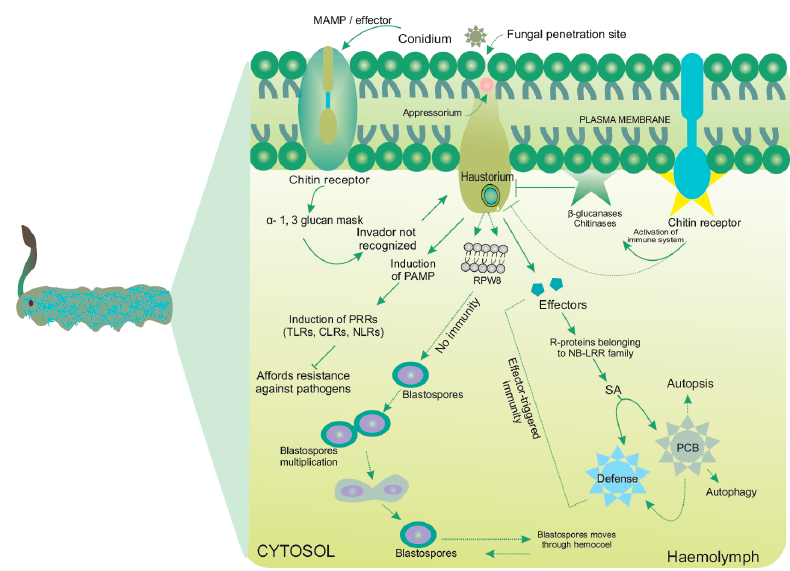
Figure 4. Detailed mechanism of fungal assault to insect larvae. Unlike in mammals, fungal cell-wall is endowed with several glycans, glycolipids and proteins. PAMPs trigger upregulation of immunity via several pathogen-recognition receptors (PRRs), such as Toll-like receptors (TLRs), C-type lectin receptors (CLRs) and NOD-like receptors (NLRs). CLRs such as N-linked mannans, galactomannans, β -1,3 glucans, α -mannals and α -mannosyl residues are detected by MR, DC-SIGN, Dectin 1, Dectin 2 and MINCLE, respectively. RPW8: Atypical resistance protein. DC-SIGN: Dendritic cell-specific ICAM3-grabbing non-integrin, MAMP: Microbes-associated molecular pattern, MINCLE: Macrophage-inducible C-type lectin, MR: Mannose receptor, NB-LRR: Nucleotide binding leucine-rich repeat domain, NOD: Nucleotide-binding oligomerization domain-containing protein, PAMP: Pathogen-associated molecular pattern, PCB: Polychlorinated biphenyls, SA: Salicylic Acid [36,56,80]. Solid and dotted arrows represent detail molecular mechanism in most entomopathogens and Cordyceps sp. respectively, while T-arrows represent resistance mechanism of the insects against the invading pathogens.